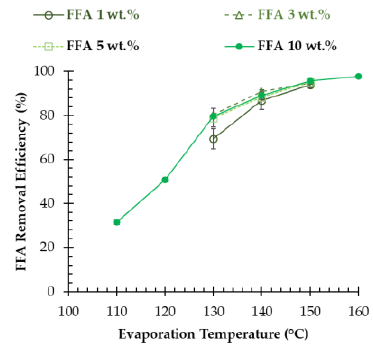
evaporation Figure 4. FFA removal efficiency of feeding mixture with 1 – 10 wt.% FFA content as affected by evaporation temperature .